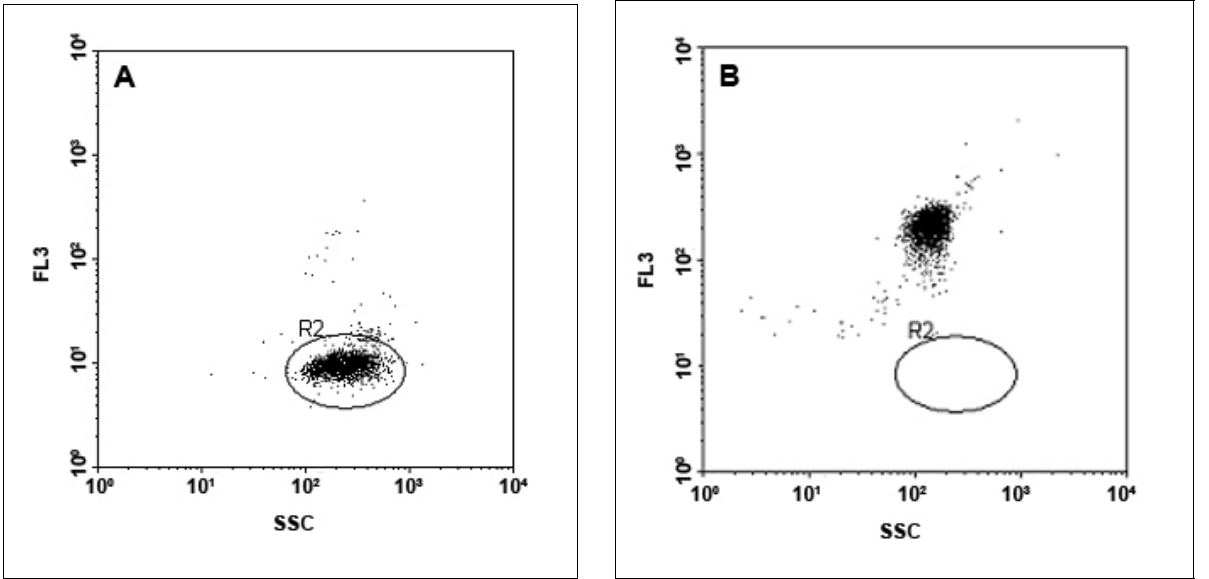
Figure 8. Flow cytometric analysis of QD655 bound to Dynabeads. Bivariate dot-plots defining log FL3 channel (y-axis) versus log SSC channel (x-axis) A;